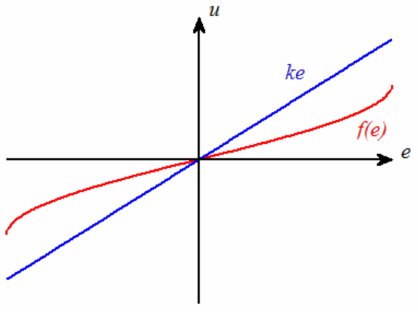
Figure 2. Characteristic of single-input single-output nonlinear